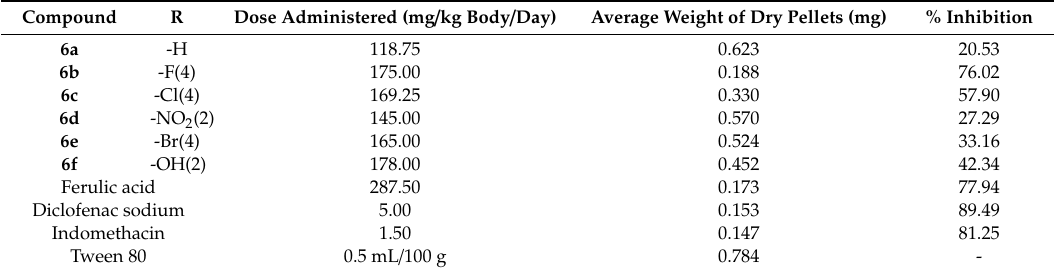
Table 4. E ff ect of the azetidine-2-one derivatives ( 6a–f ) on the proliferative process (granulation tissue formation) of chronic inflammatory edema induced in